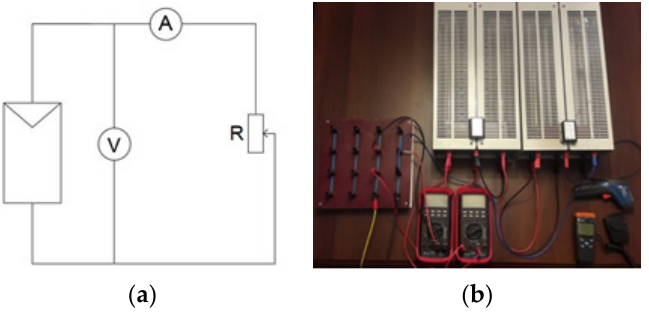
Figure 4. ( a ) The measurement system diagram; ( b ) the measurement system photographs. The module edge rested on the ground at each of the measurements. Measurement of solar irradiance intensity on the module surface was conducted each time before voltage and current measurements. The solar irradiance intensity was measured at 12 points and then averaged. These values might have changed during the measurement, as the tests were performed in natural outdoor conditions. In central Poland, the measurements were performed in the vicinity of Pozna´n (52 ◦ 05 (cid:48) N, 16 ◦ 54 (cid:48) E) in September and October 2020. Figure 5 demonstrates the total energy of solar irradiance in particular locations in Poland. The average annual total energy in the indicated location was approx. 1080 kWh/m 2 . The average monthly radiation energy was 103.7 kWh/m 2 /month in September and in October 59.2 kWh/m 2 /month. The average monthly temperature in September was 14.93 ◦ C, in October—9.33 ◦ C [37]. The measurements were performed on days with different ambient temperatures and solar irradiance, which made it possible to obtain a spectrum of various atmospheric conditions, ranging from high cloudiness when the radiation density was approx. 60 W/m 2 , to an insolation of up to 1100 W/m 2 .